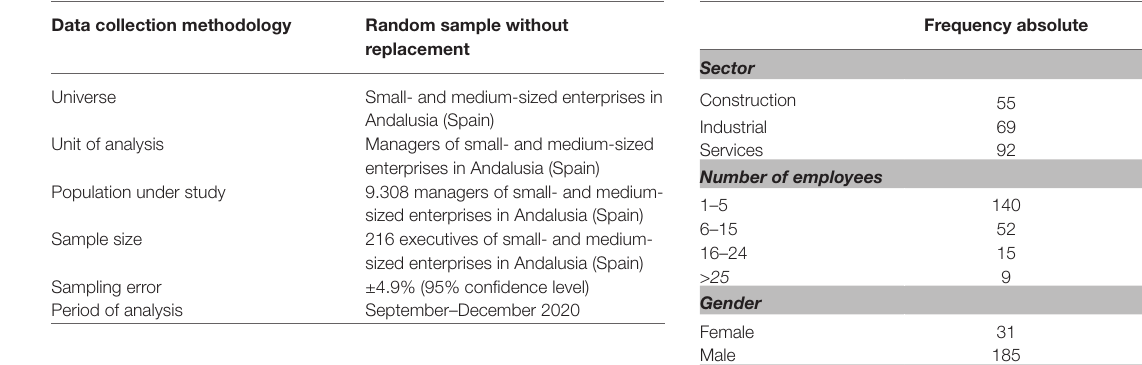
TABLE 1 | Technical specifications of the sample. TABLE 2 | Characteristics of the